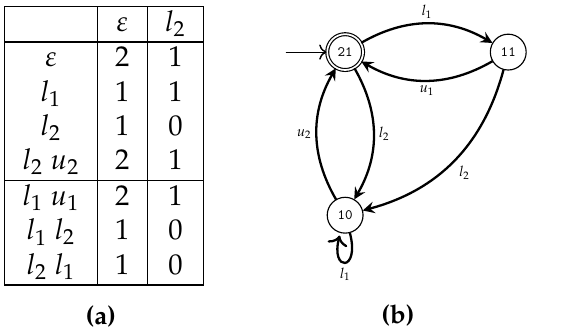
Figure 4. L ∗ – The initial table Figure 5. L ∗ – First Iteration Figure 5. L ∗ —First iteration. ( a ) The initial table made closed and consistent; ( b ) first hypothesis.